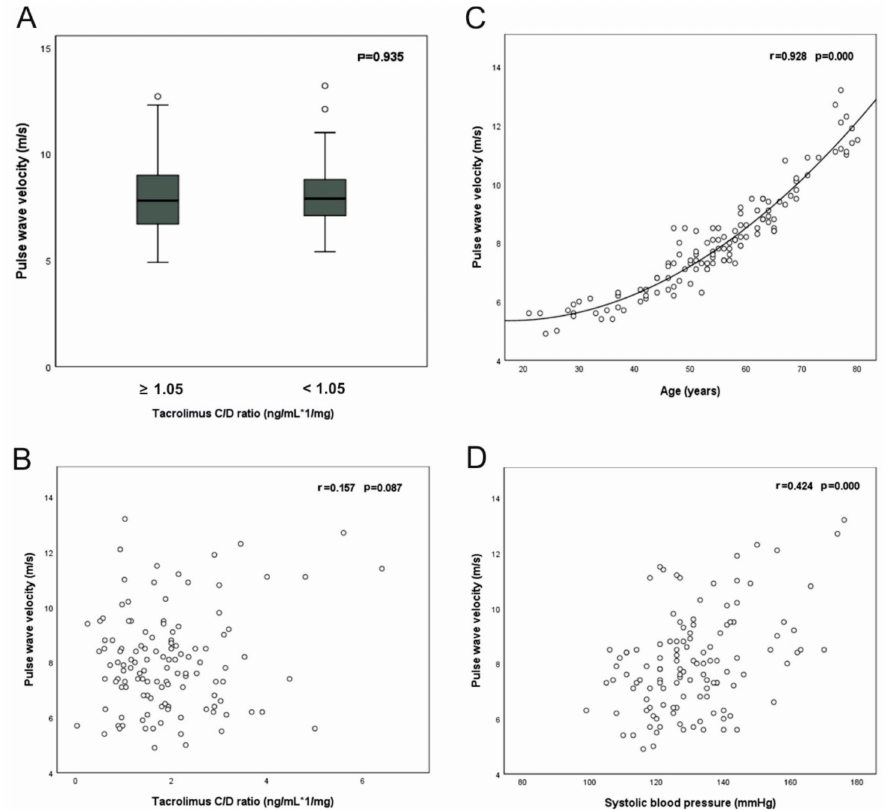
Figure 5. Pulse wave analysis of kidney transplanted patients. No correlation was observed between the C / D ratio and pulse wave velocity ( A , B ). The scatter plot in ( C ) indicates a strong quadratic relation of age and pulse wave velocity. Systolic blood pressure showed a moderately strong correlation to pulse wave velocity ( D ). R: Pearson correlation coe ffi